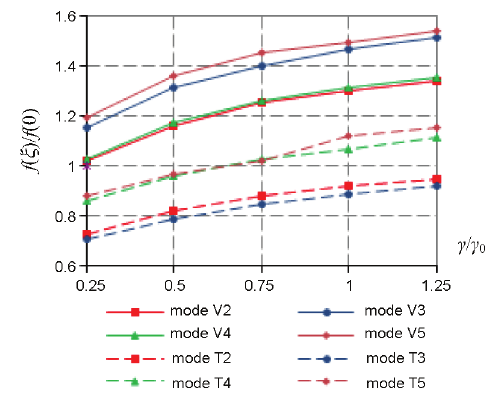
Fig. 13. The ratio between the frequency of the model with stiffened cables f ( ξ ) and that of the original system f (0) for all vertical and torsional modes versus the ratio γ/γ 0 of the mass density of the deck considering the stiffness parameter ξ = 2.0 of the